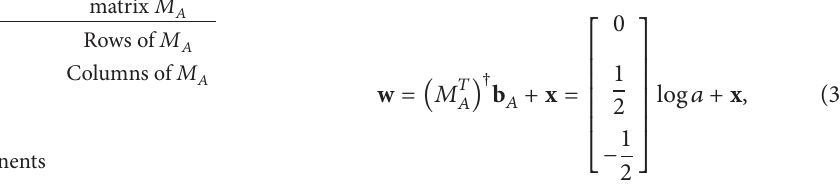
Table 1: Notation. Table 1 we have 𝑛 = 3 , 𝑚 = 1 , 𝑘 = 2 , and 𝑝 = 2 . Any solution of 𝑀 𝑇 𝐴 w = b 𝐴 is given